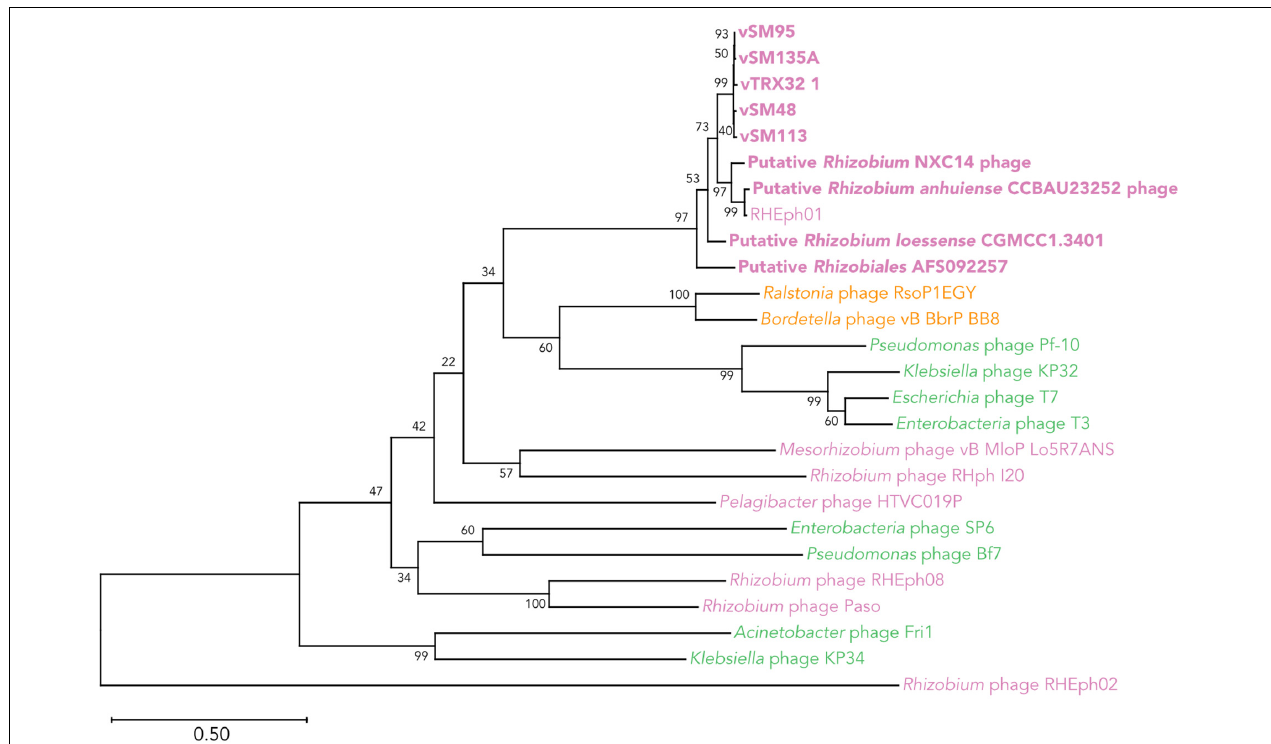
FIGURE 7 | Phylogenetic relationship of the TRX32-1 like phages in and the wider Autographiviridae clade based on DNA-dependent RNA Polymerase protein sequences. The vTRX32-1-like phages are shown in bold along with representative examples of the larger Autographiviridae clade. Label color indicates the class of host bacteria for each phage; pink = Alphaproteobacteria, yellow = Betaproteobacteria, green = Gammaproteobacteria. Numbers by each clade indicate the percent of bootstrap replicates that support each